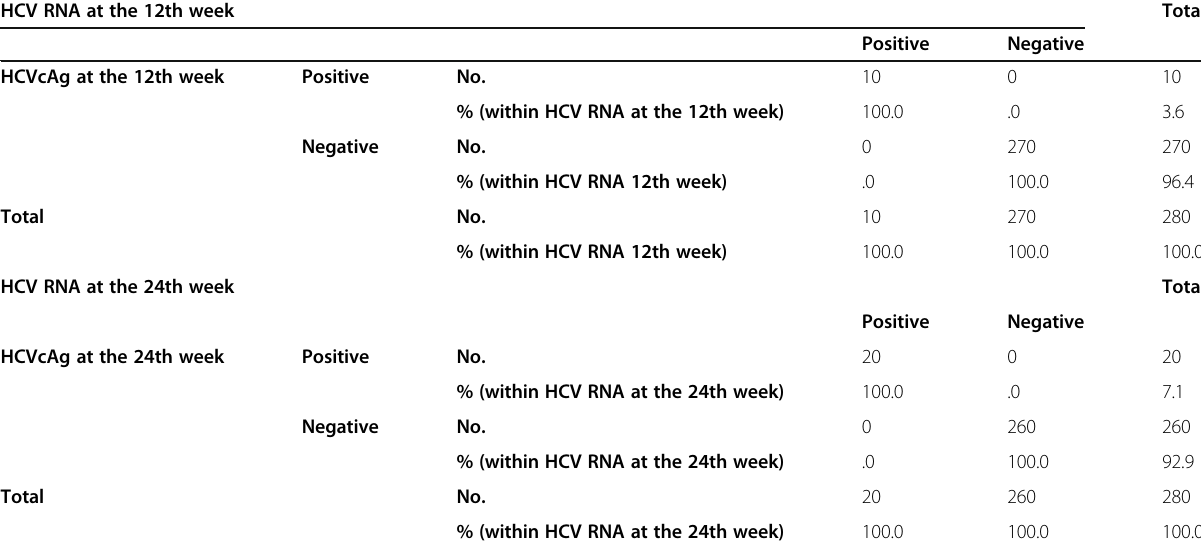
Table 7 Degree of agreement between HCV RNA and HCVcAg results at the 12th and 24th week among the studied groups HCV RNA at the 12th week